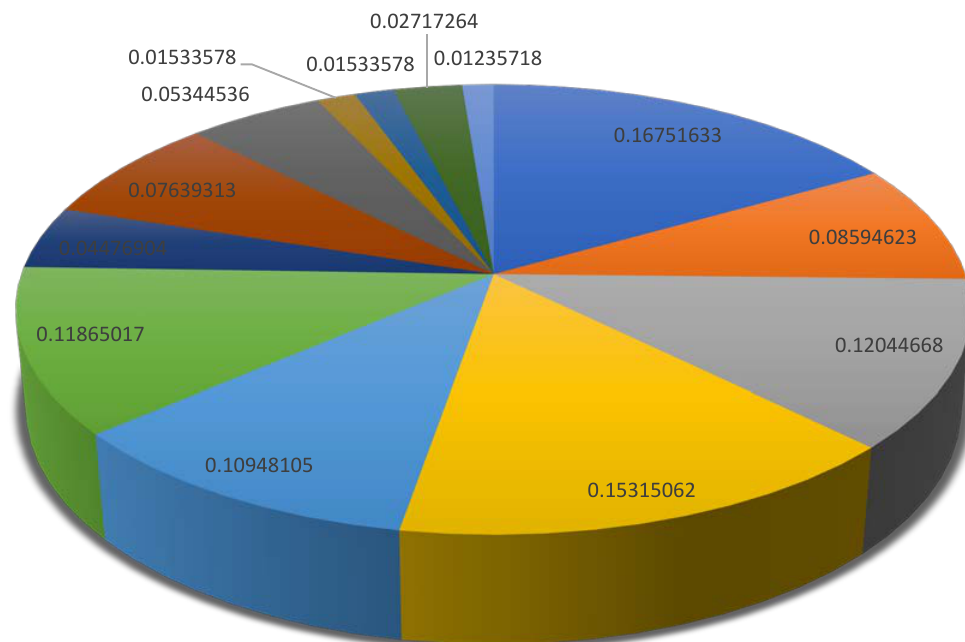
Figure 4. The weights representing decision-makers’